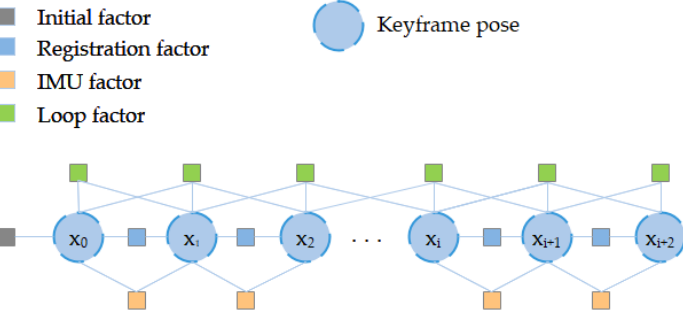
Figure 5. Factor diagram optimization